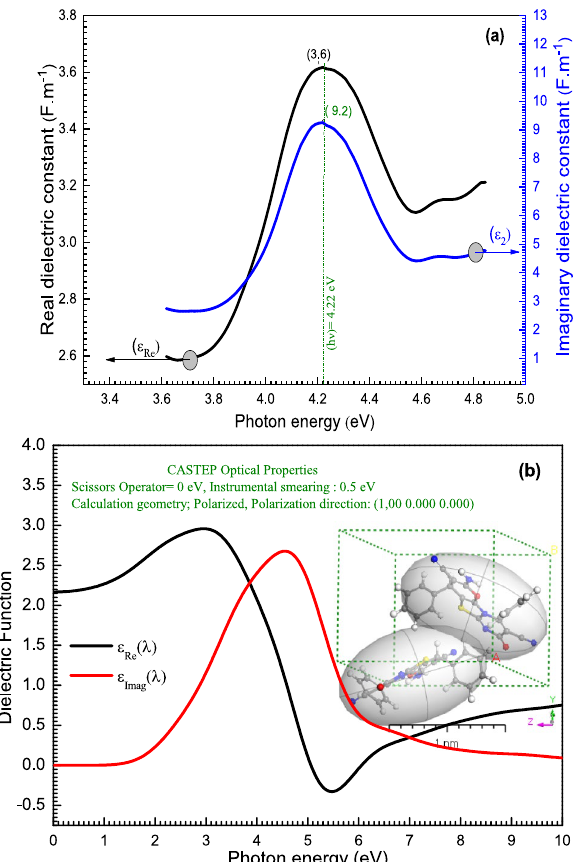
Figure 10. ( a ) The experimental ε Re (λ) & ε Imag (λ) for [ThiPy-3,8-Dc] TF . ( b ) Simulated ε Re (λ) & ε Imag (λ) for [ThiPy-3,8-Dc] Iso as an isolated state using the CASTEP